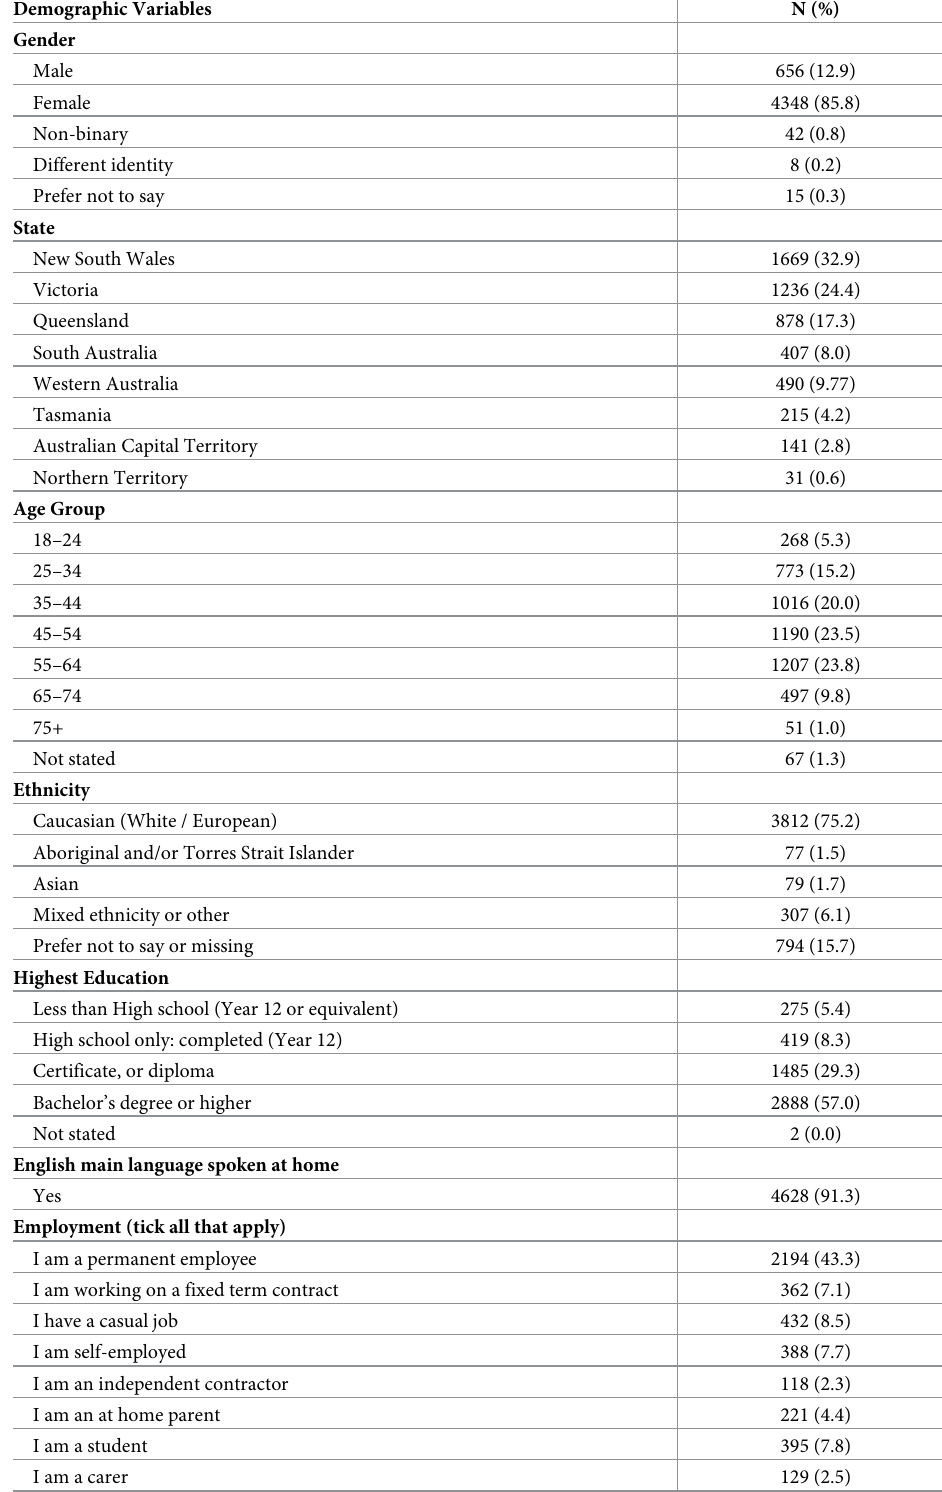
Table 1. Demographic characteristics of the